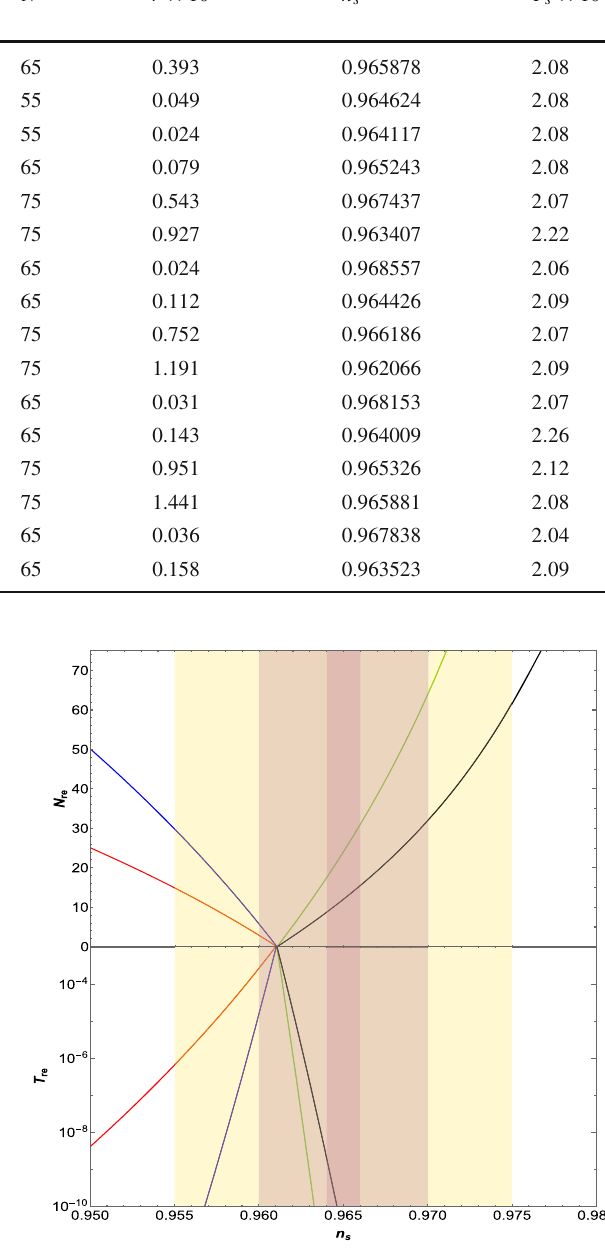
Fig. 6 For the choice of n = 3 , q = 2, Plots of N re and T re as a = 0, the green line re function n s for different values of w re . The red line corresponds to w = − 1 / 3, the blue line corresponds to w re corresponds to w re = 2 / 3 and finally the black line corresponds to w = 1. The light pink shaded region corresponds to the 1- σ bounds re and yellow shaded region corresponds to the 2- σ bounds on n s from Planck’18 [TT,TE,EE+lowE+lensing+BK15].Thedarkpinkshaded region corresponds to the 1- σ bound of future CMB observations [52, 53] using same central value for n